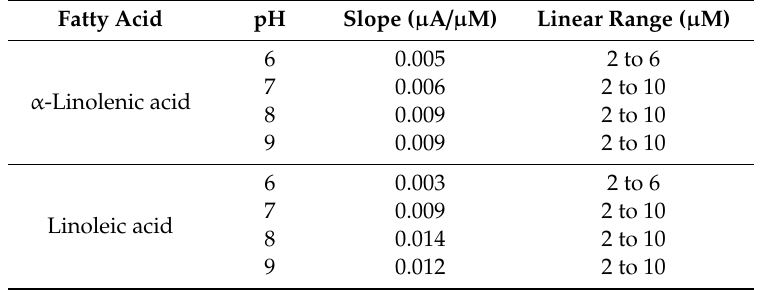
Table 1. Slopes and linear ranges of α -linolenic and linoleic acid at 25 ◦ C and pH 6.0, 7, 8.0 and 9.0. Fatty Acid pH Slope ( µ A / µ M) Linear Range ( µ M)